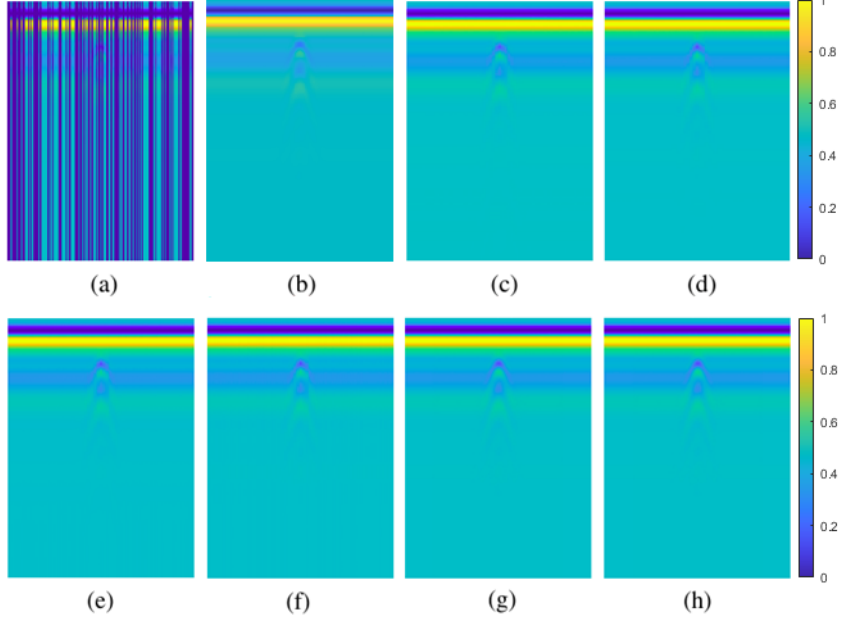
Figure 12. 50% column-wise missing data case for simulated data: ( a ) GPR image with missing entries, ( b ) original GPR image, recovered images by ( c ) GoDec, ( d ) NMC, ( e ) Lmafit, ( f ) NNM, ( g ) PEN-Net, ( h )